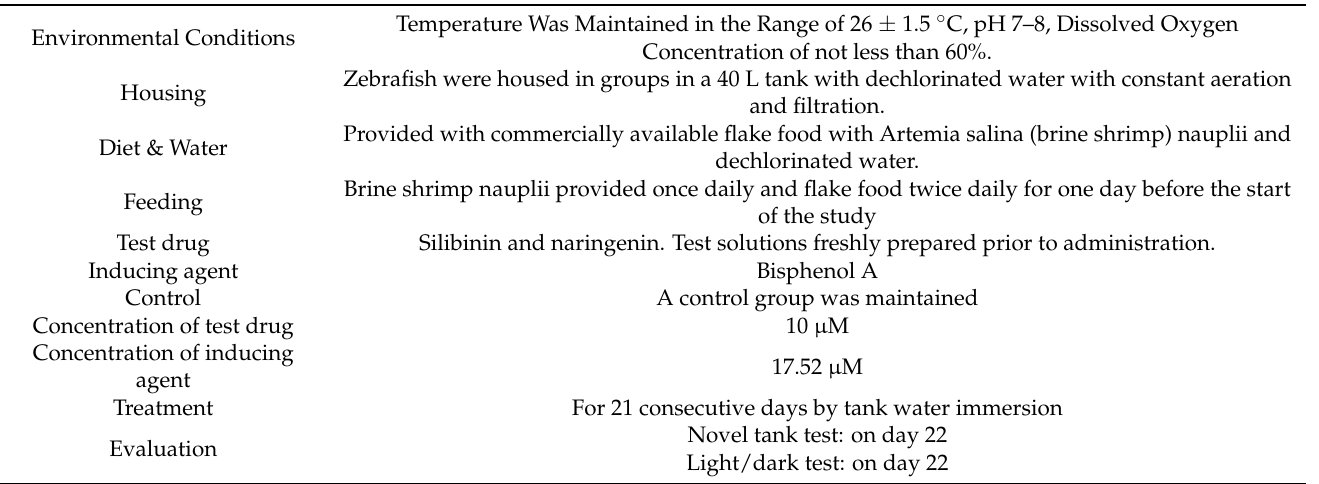
Table 2. Experimental design for neuropharmacological